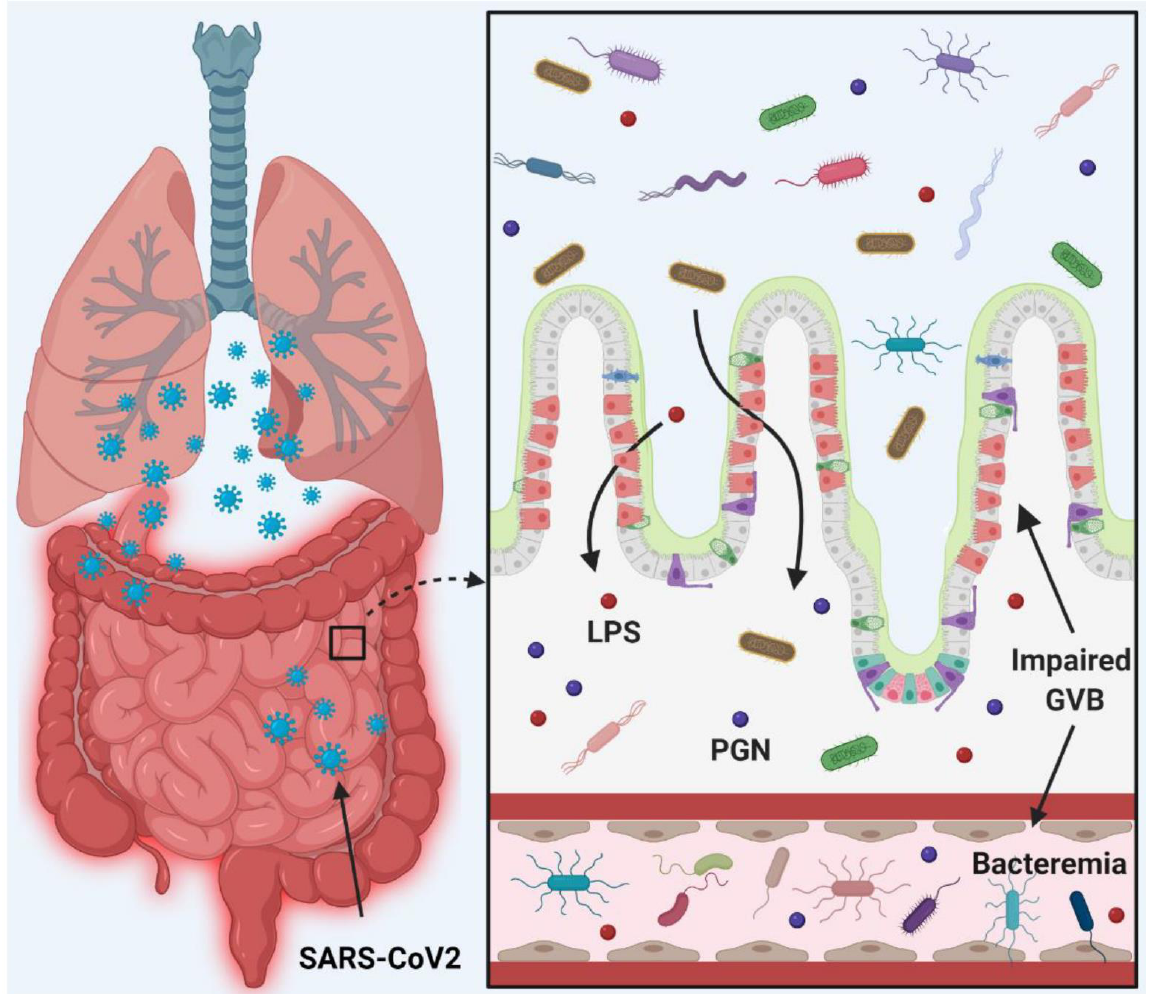
Figure 5. Schematic diagram representing the hypothesis of COVID-19 infection promoting gut barrier defects and translocation of the gut microbiome into the systemic circulation, resulting in worsened outcomes. This figure was generated via Biorender.com.